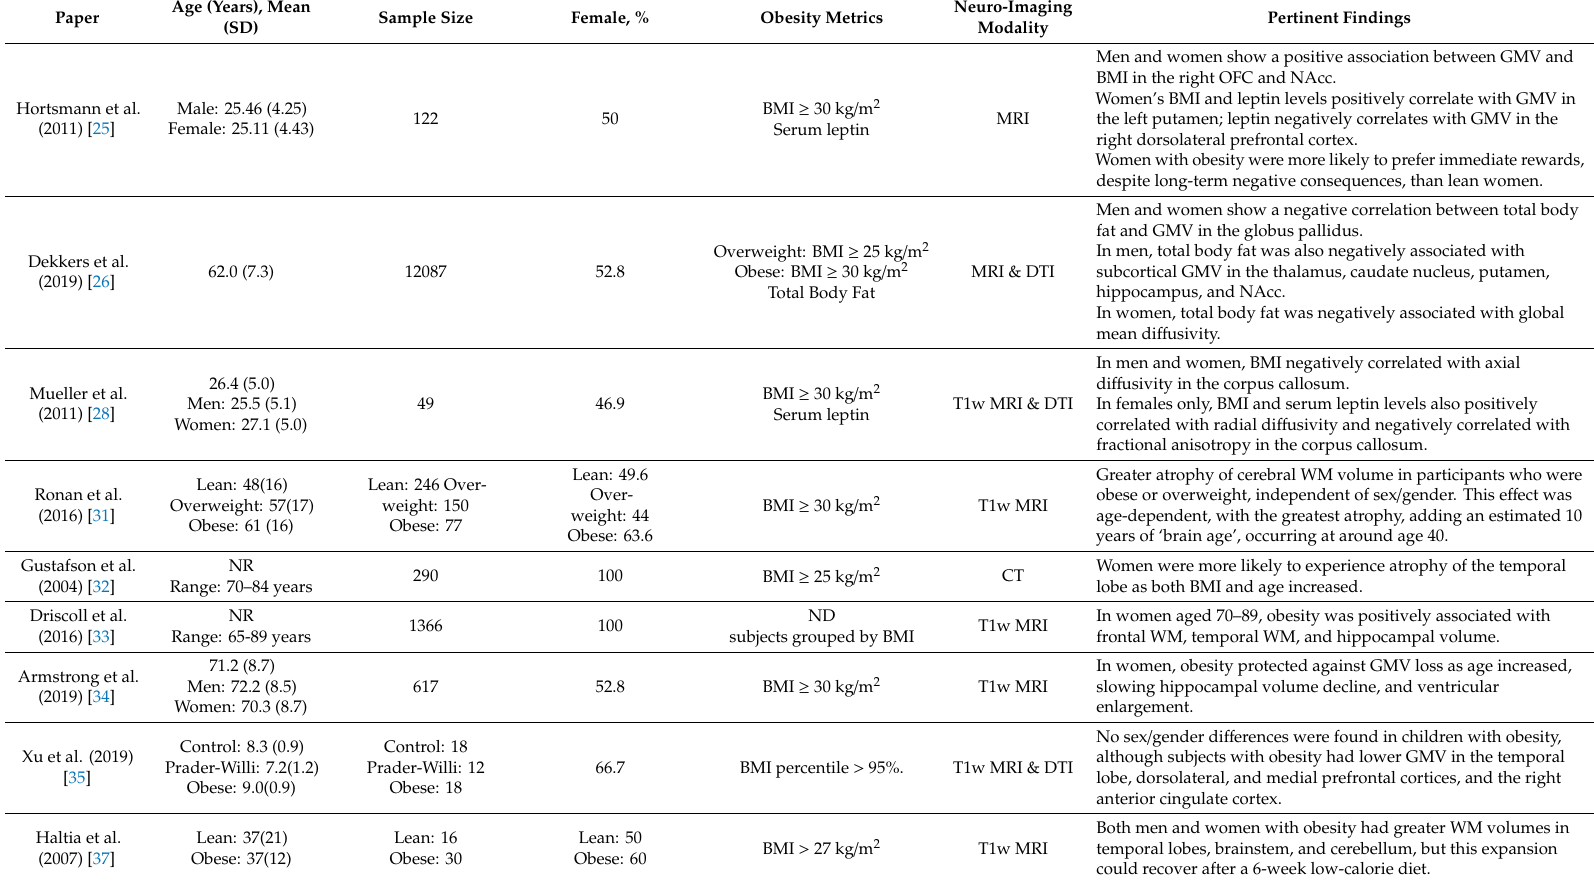
Table 1. Brain structure study sample characteristics and